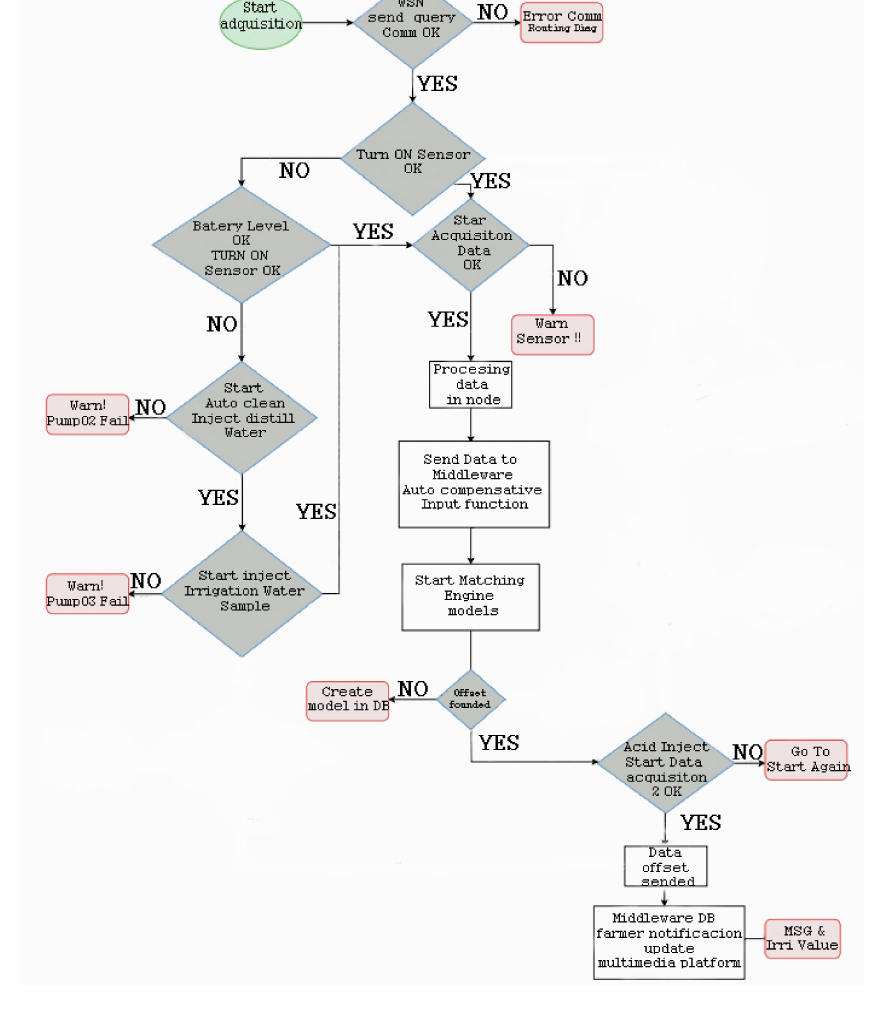
Figure 3. Flow diagram of our intelligent diagnosis